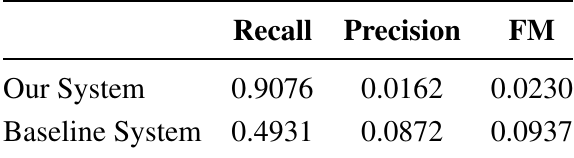
Table 1. Comparison of Clustering Results using Reuters-RCV1 Corpus.